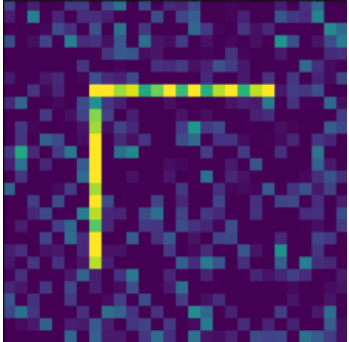
Figure 17. Level 2 noise.